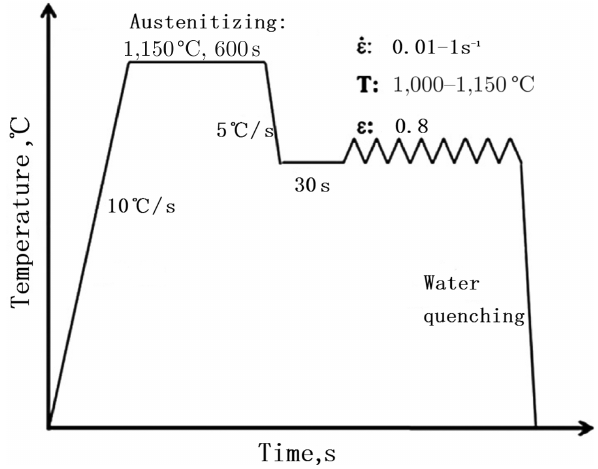
Figure 1: Schematic diagram illustrating sequence of hot compres- sion tests.